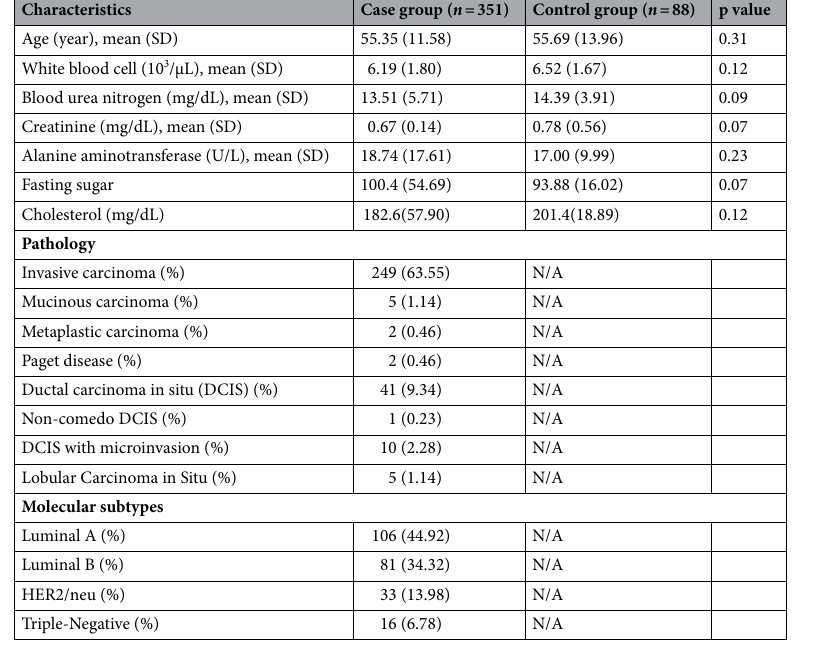
Table 1. Demographic characteristics of the study subjects.